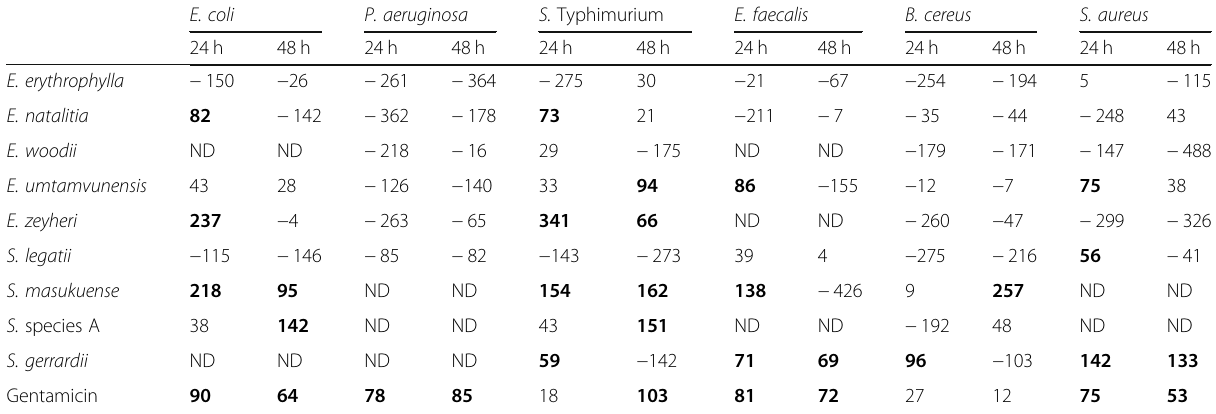
Table 5 Effect of acetone crude leaf extracts of nine plants against Gram-negative and Gram-positive bacteria after 24 and 48 h pre- formed biofilm expressed as percentage ( % ) biofilm inhibition. The numbers > 0% ≤ 50% indicates low activity, > 50% (in bold) indicates high activity against the bacteria. Negative values denote enhancement of biofilm [44]